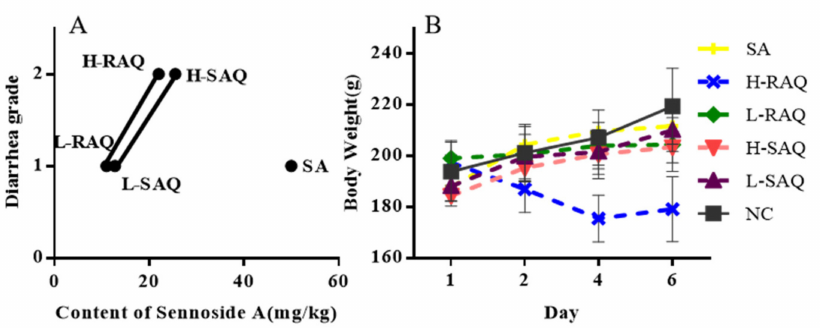
Figure 2. The male SD rats were treated without (NC) or with senna anthraquinones at low (L-Scheme 6 days). ( A ) SA content and diarrhea grade of the rats (1, 2 refers to loose stool and watery diarrhea, respectively). ( B ) The transition of body weight for the experimental rats.